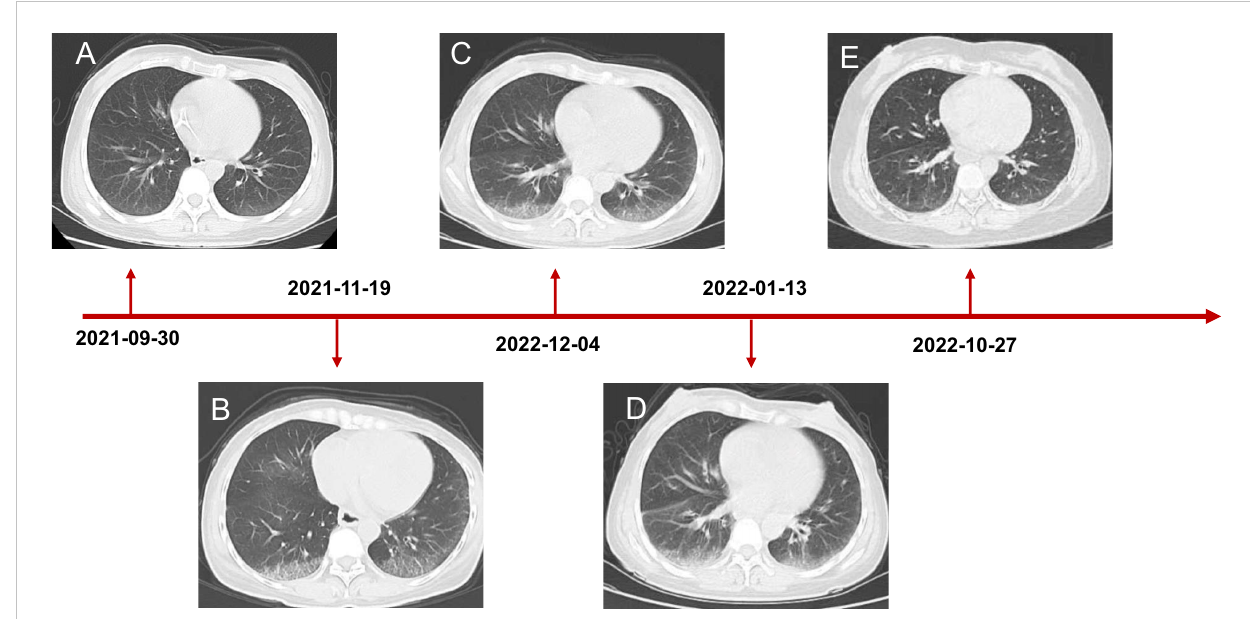
FIGURE 3 Chest CT scanning of the patient. (A) CT showed lung status without disease before treatment initiation. (B) The patient developed interstitial pneumonia after three cycles of mFOLFOX6 and bevacizumab. (C) CT demonstrated lung injury did not progress after fi ve cycles of chemotherapy and targeted therapy. (D) Interstitial lung disease still existed but did not worsen after two cycles of envafolimab. (E) The lung disorder even reversed after the patient challenged envafolimab 400mg every three weeks.